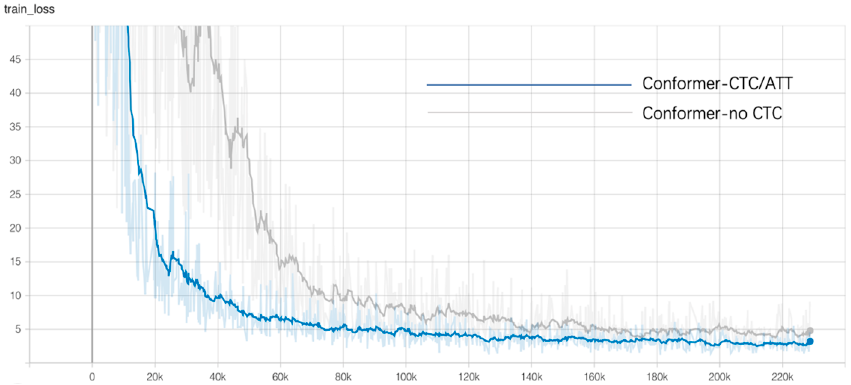
Figure 5. The train loss with and without CTC as an auxiliary task.